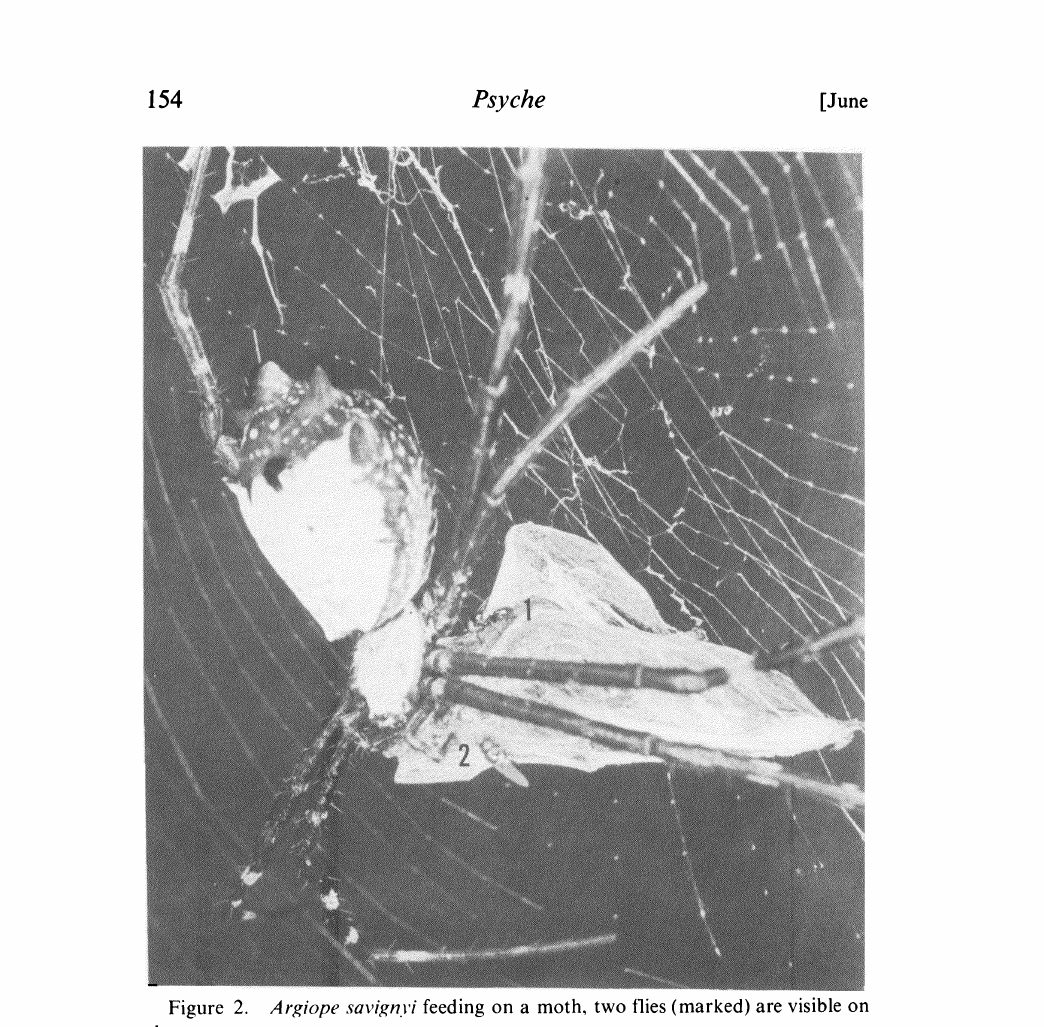
Figure 2. Argiope savign.vi feeding on a moth, two flies (marked) are visible on the